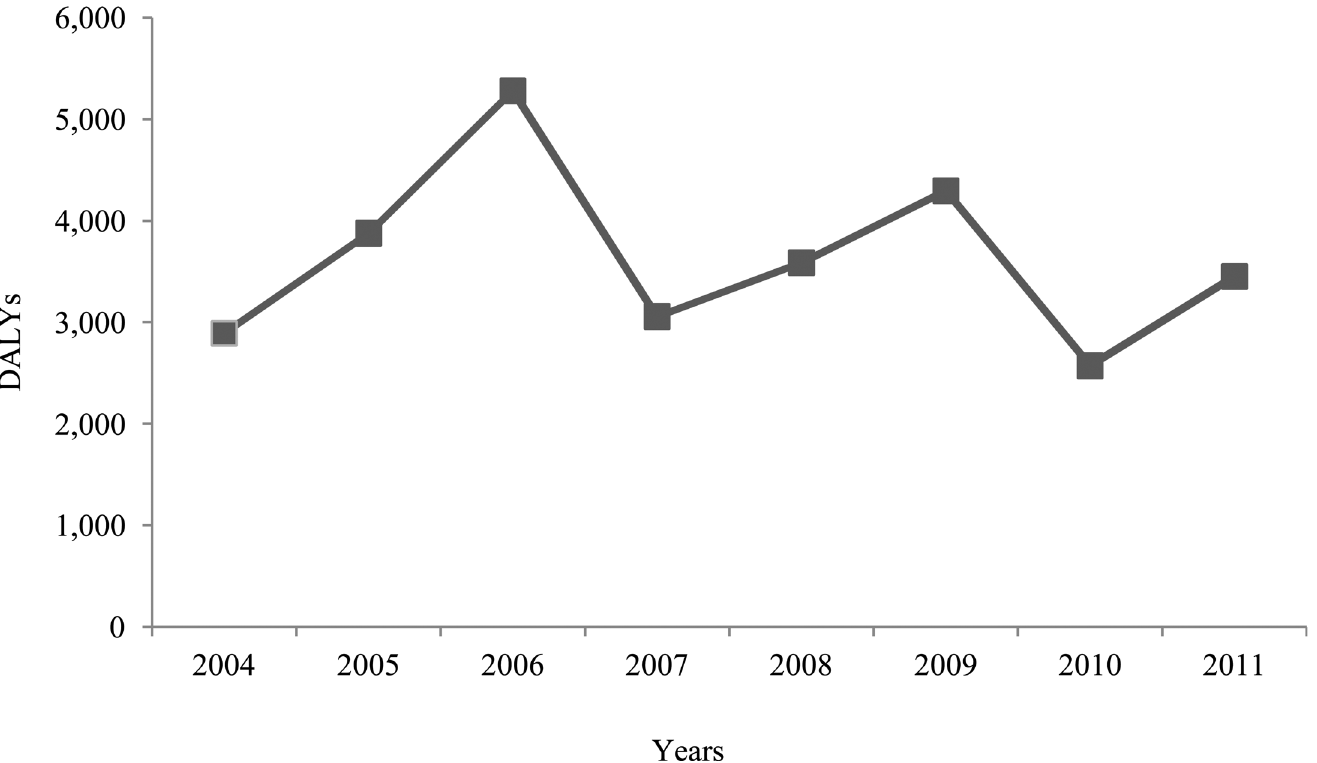
Fig 3. Trend analysis of TBE burden expressed in total DALYs in years 2004 to 2011 from the population